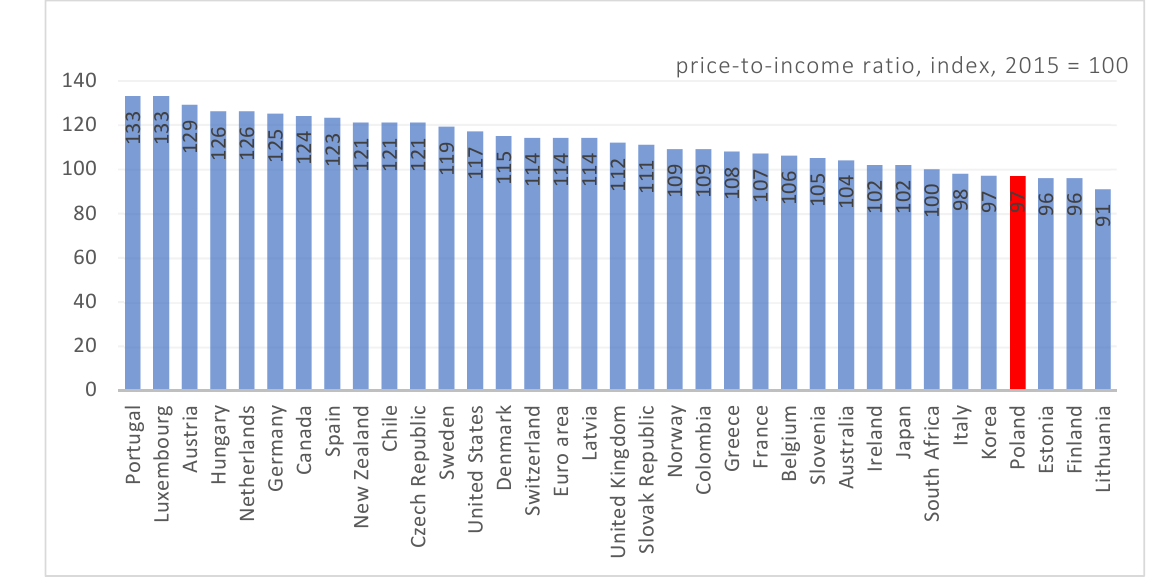
Figure 4. Price-to-income ratio around the World (2020:Q4 or latest available index, 2015 = 100). Source: Organisation for Economic Co-operation and Development.